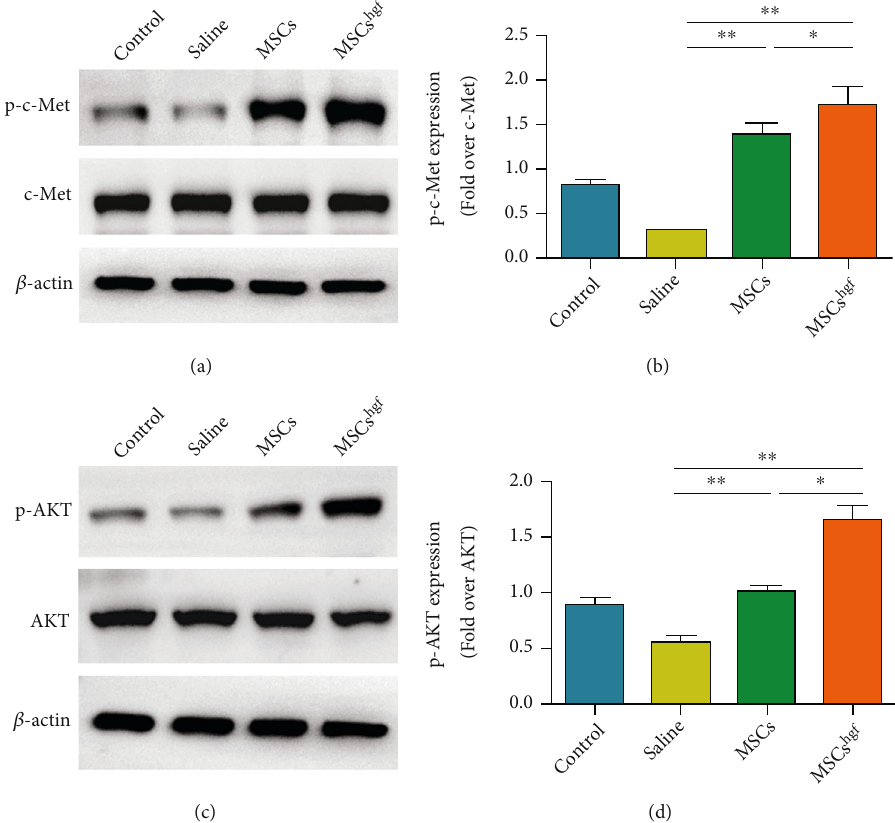
Figure 6: HGF gene-transfected MSCs activate phosphorylated c-Met and the downstream phosphorylated AKT pathway. (a) Representative images of p-c-Met in each treatment group. (b) Densitometric analysis of changes in the abundance of phosphorylated c- Met normalized to c-Met for loading variability. (c) Representative images of p-AKT in each treatment group. (d) Densitometric analysis of changes in the abundance of phosphorylated AKT normalized to AKT for loading variability. ( ∗∗ P < 0 : 01 , ∗ P < 0 : 05 , n = 3